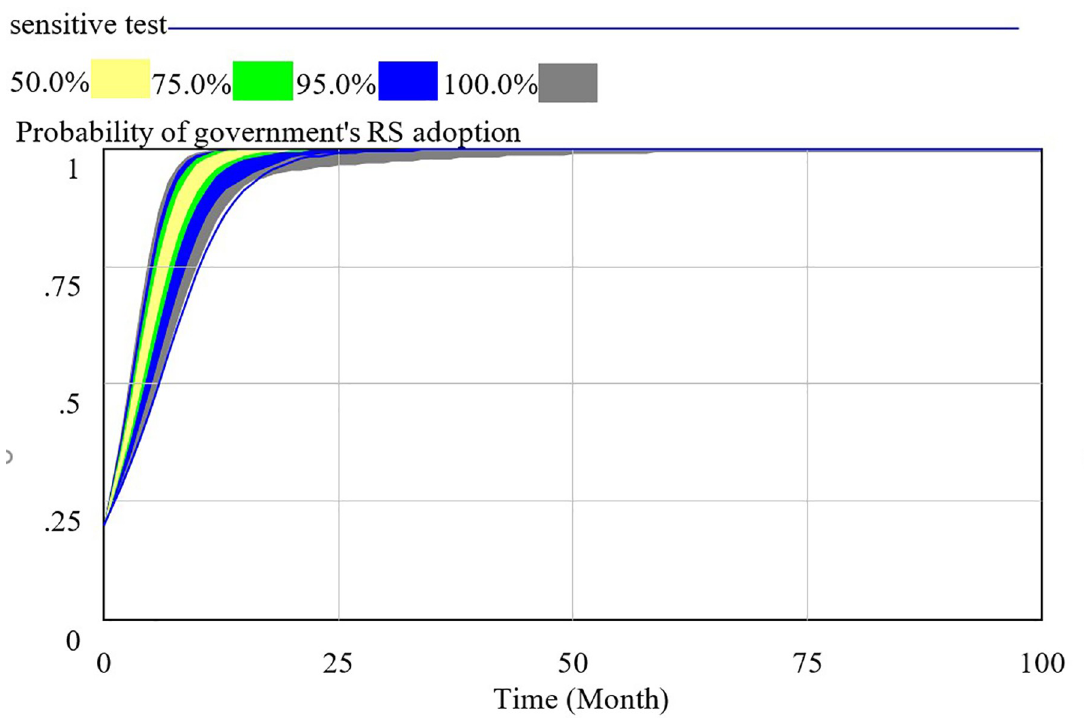
Fig 5. Sensitivity analysis of government’s strategy selection.